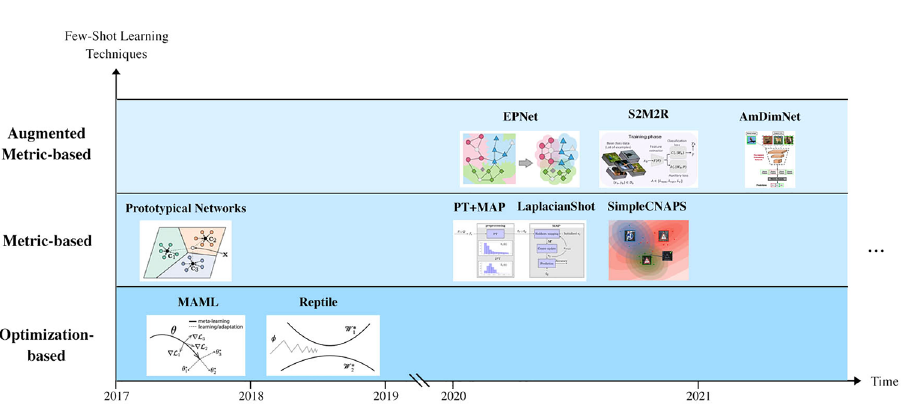
Figure 2. A temporal overview of notable few-shot learning techniques proposed within the past 5 years. "Optimization-based" few-shot learning techniques refer to those proposing changes to optimization processes employed by a network. "Metric-based" few-shot learning techniques refer to those proposing a metric from which a similarity score between a set of samples can be obtained from. "Augmented Metric-based" few-shot learning techniques refer to those proposing an augmentation (such as application of a self-supervised or transductive process) to a metric-based few-shot learning